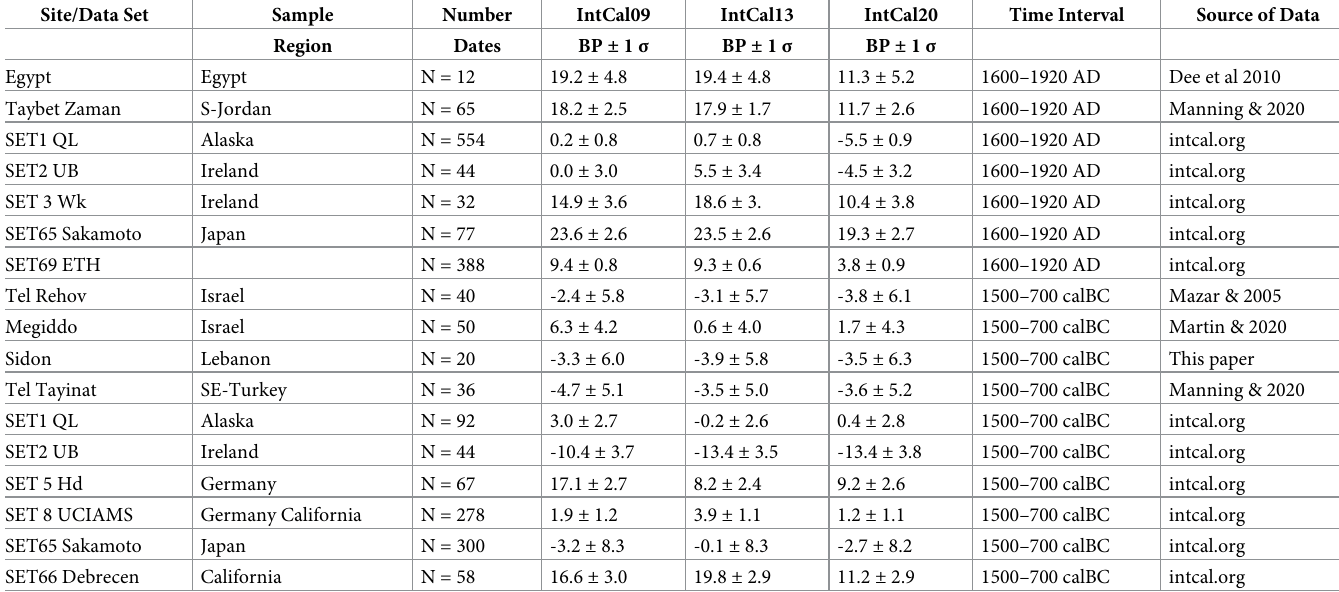
Table 2. 14 C-offset